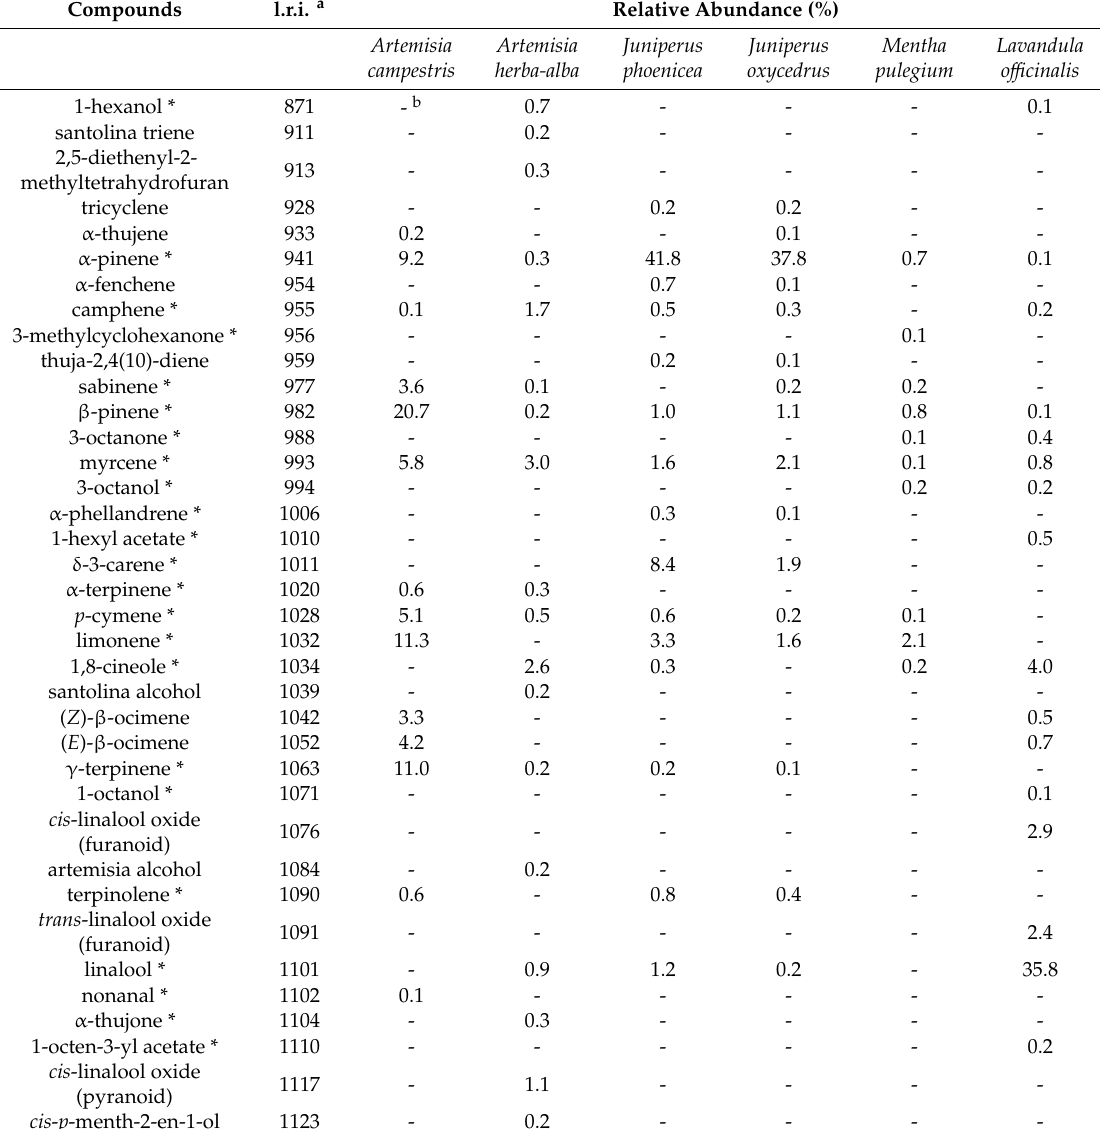
Figure 6. GC chromatogram of the EO hydrodistilled from the aerial parts of L. o ffi cinalis Chaix. Table 2. Complete compositions of the essential oils hydrodistilled from the aerial parts of the six Algerian species selected in the present